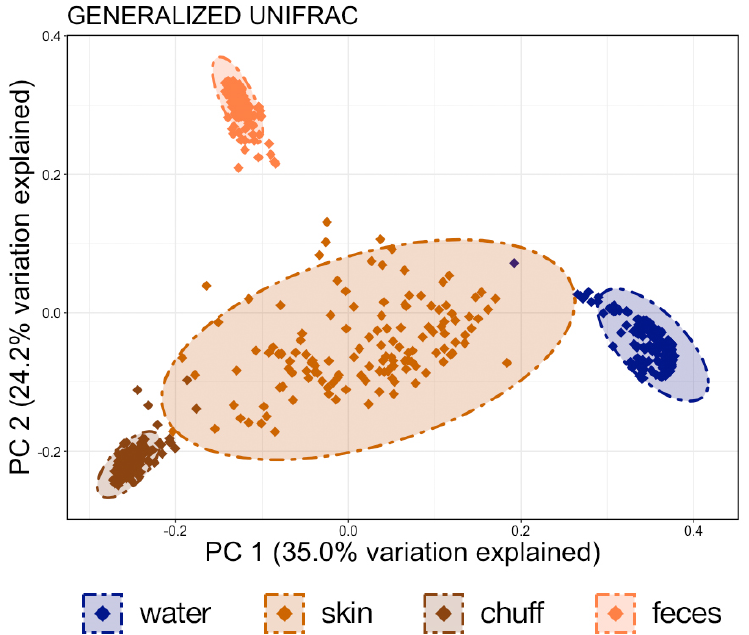
Figure 2. Principal co-ordinates analysis (PCoA) of generalized UniFrac distances illustrating dif- ferences in microbial community composition between all samples across all timepoints. The PCoA demonstrates clustering of 16S rRNA gene sequences from water ( n = 149), skin ( n = 130), chuff ( n = 142), and fecal ( n = 144) microbial communities. Ellipses represent 99% confidence ellipses for each sample type.